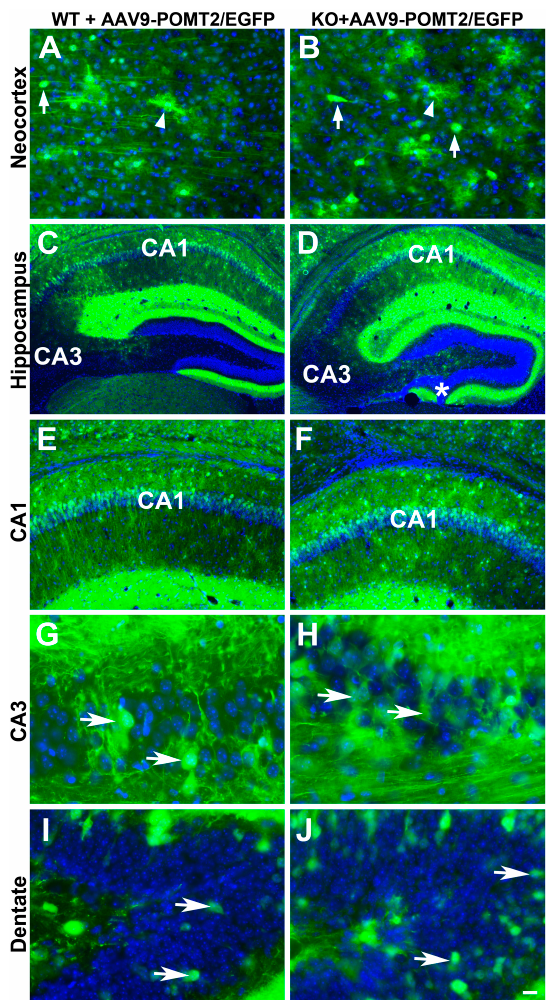
Figure 2. Neocortical and hippocampal neurons were efficiently transduced by the viral vector in wildtype and cerebral cortex-specific POMT2 knockout animals. GFP fluorescence micrographs of cerebral cortex-specific knockout and wildtype mice injected with viral mixtures of adeno-associated viral vector 9 (AAV9)-POMT2 and AAV9-EGFP at birth and analyzed at five months of age. ( A , B ) Examples of labeled neurons (arrows) and astrocytes (arrowheads) in the neocortex of wildtype and knockout mice. ( C , D ) EGFP fluorescence in the hippocampus; ( E , F ) CA1 region of the hippocampus. ( G , H ) CA3 region of the hippocampus; ( I , J ) Dentate gyrus. Abbreviations: KO, knockout; WT, wildtype. Scale bar: 25 μ m for ( A , B , G , H ); 100 μ m for ( E , F ); 200 μ m for ( G , H ).